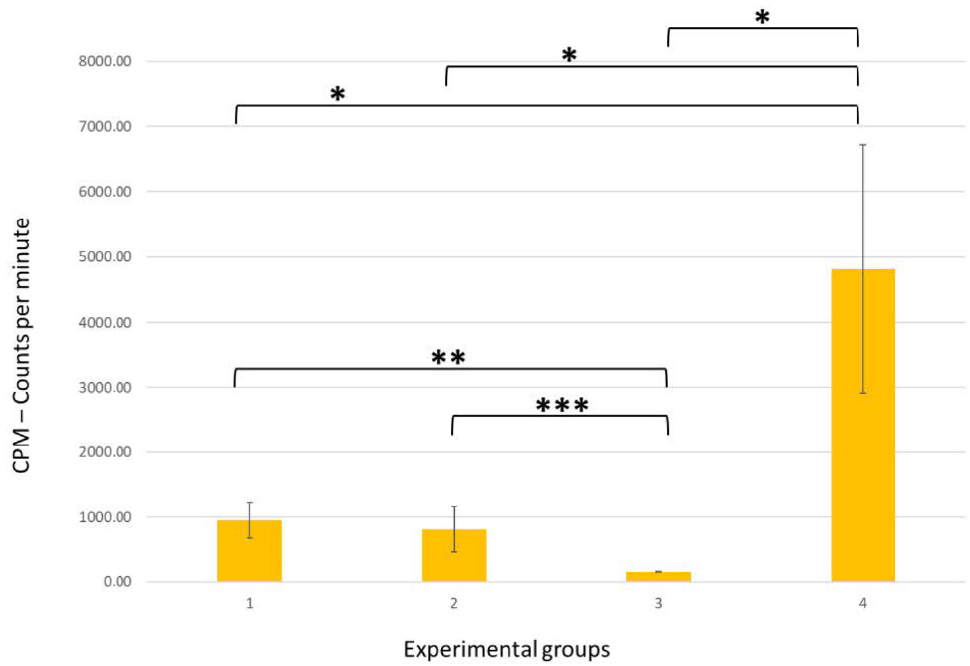
Figure 2. Visual representation of mean values and standard deviation of the total counts in each group and the significance level between groups: * p < 0.05; ** p < 0.01; *** p < 0.001; ns—not significant; Y-axis—CPM—the measurement count of the radioactive isotope per minute; X-axis—groups—1 and 2 (experimental groups), 3 (negative control group), and 4 (positive control group) .